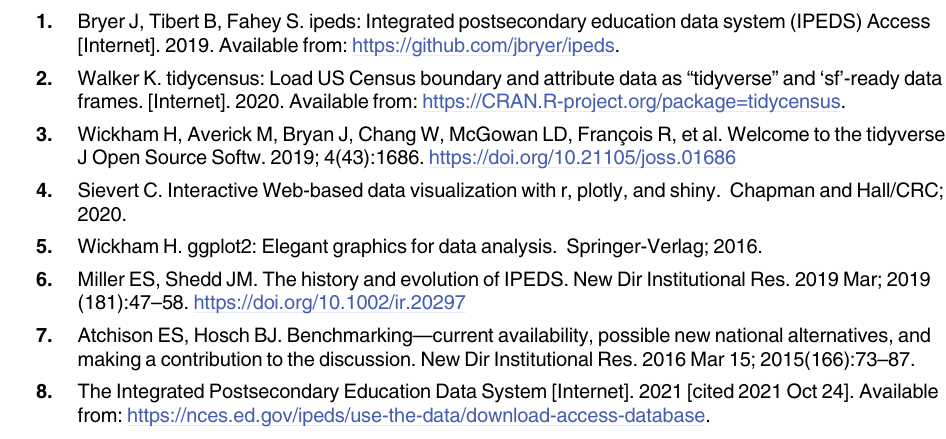
S1 Table. R package libraries used to develop the